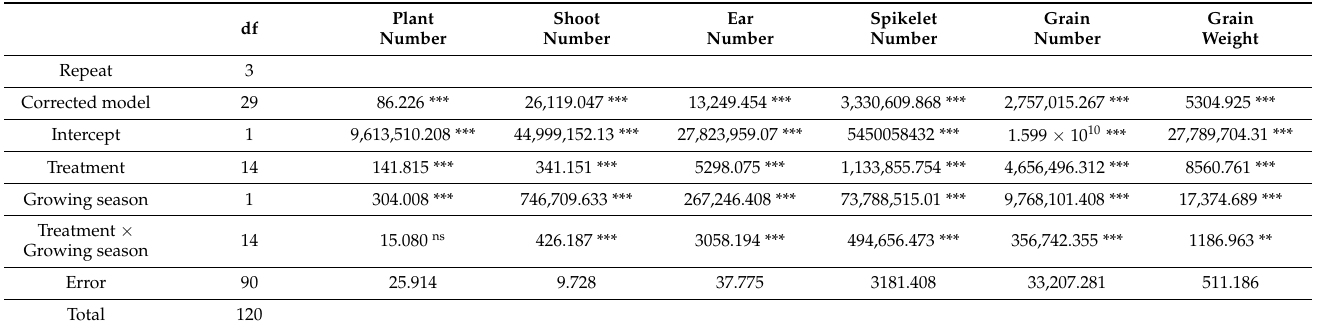
Table 9. Results of variance analysis of winter wheat ( Triticum aestivum L.) yield components (MS).